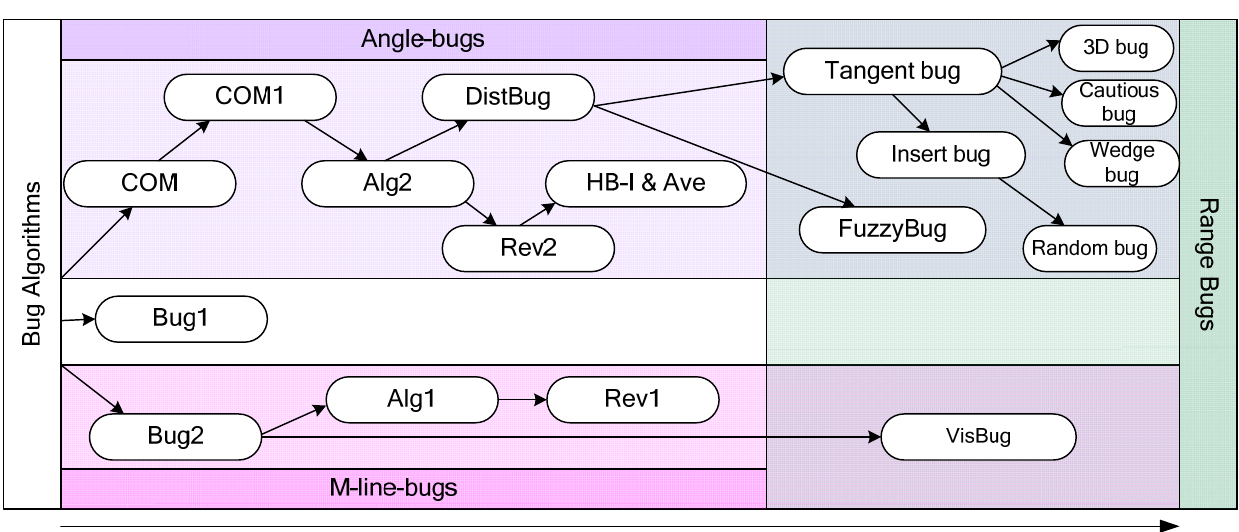
Figure 5. Bug-type algorithms classification.